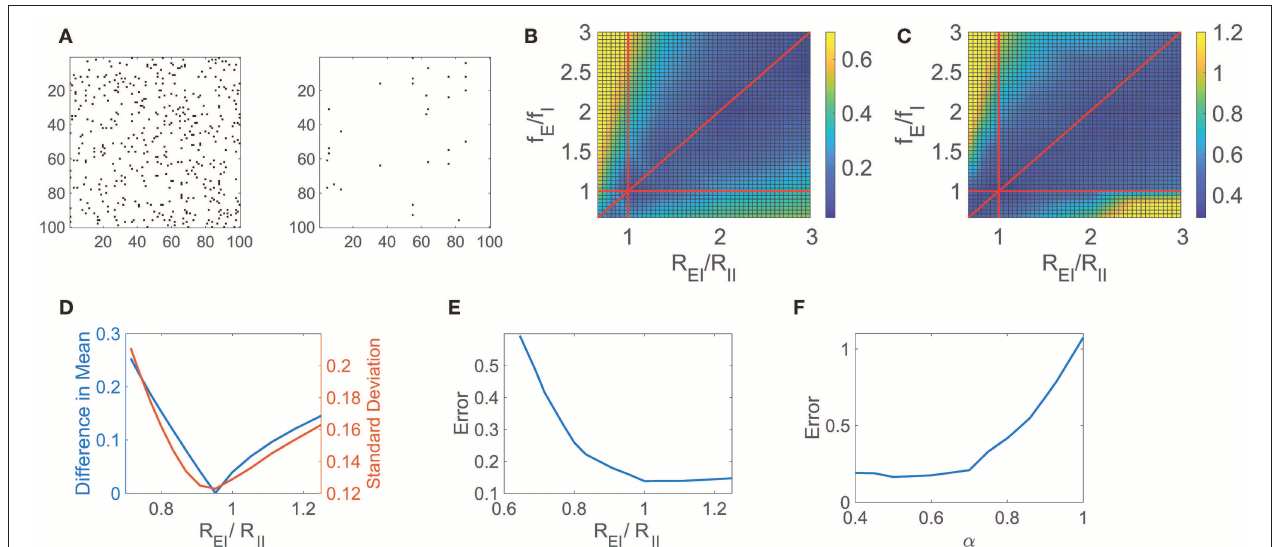
FIGURE 2 | CS network reconstruction and dynamical regime. (A) The connectivity matrix R for a 100 excitatory neuron subset of a balanced network with N E 800, = N I 200, and 0.05 connection density is depicted on the left. Existing connections are marked in black. On the right, errors in the CS reconstruction of R are marked = in black. The relative reconstruction error is ǫ 0.14. (B) Difference in absolute value between the mean of the time-averaged ratio of excitatory and inhibitory input = across the network (E/I input ratio) and 1, the value expected in the balanced state, as a function of the quotients R EI / R II and f E / f I . (C) Relative reconstruction error − f E / f I . (D) Statistics of the E/I input ratio across the network as a of R as a function of R EI / R II and f E / f I . In (B,C) , red lines denote R EI / R II 1, f E / f I 1, and R EI / R II = = = function of R EI / R II for fixed f E / f I 1.2. Left ordinate axis: Difference in absolute value between the mean E / I input ratio and 1, Right ordinate axis: Standard deviation = − of E / I input ratio. (E) Relative reconstruction error of R as a function of R EI / R II for fixed f E / f I 1.2. (F) Relative reconstruction error of R as a function of the exponent = α . Each reconstruction utilizes r 900 inputs with 2.5 s observation =